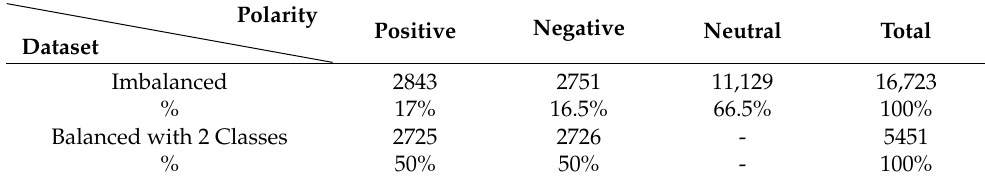
Table 3. Balanced dataset with binary